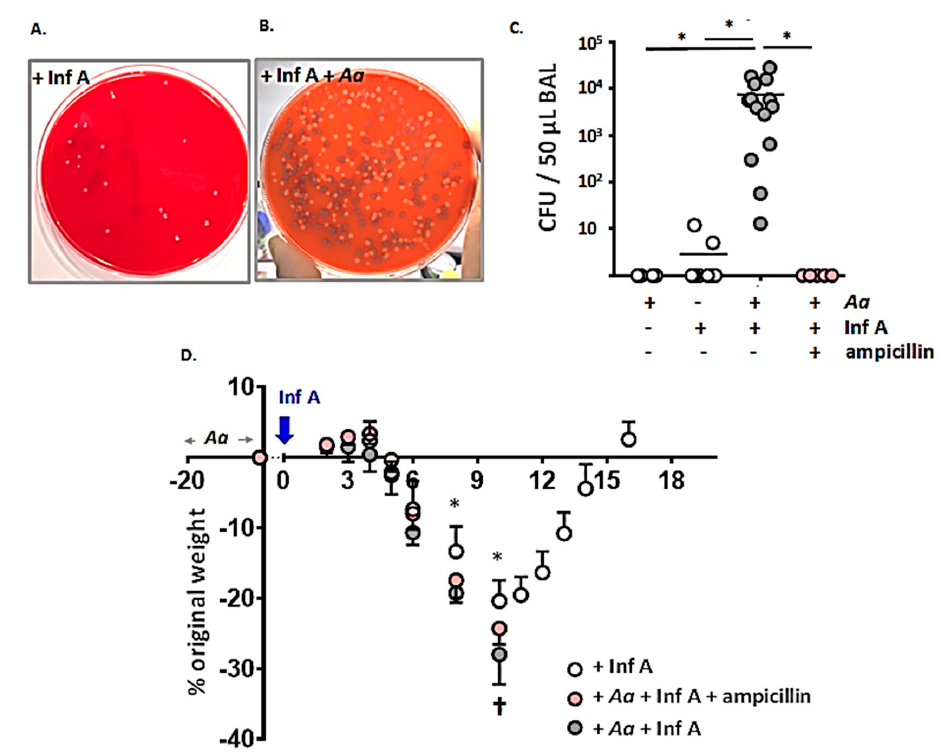
Figure 4. Bacterial colonization of the airways of A. alternata -challenged, Inf A-infected mice. Overnight growth at 37 ◦ C on blood agar plates streaked with dilutions of BAL fluid from ( A ) a mouse infected with a sublethal inoculum of Inf A only and ( B ) a mouse subjected to repetitive inoculation with A. alternata (5 µ g per inoculum) prior to Inf A infection. Both samples were from day 8 as per the timeline shown in Figure 1A. ( C ) Colony forming units (CFUs) per 50 µ L BAL fluid on day 8 as per the timeline in Figure 1A. Shown are results from mice challenged with A. alternata alone, sublethal Inf A alone, A. alternata followed by Inf A, and A. alternata followed by Inf A and ampicillin (20 mg / mouse / day i.p. on days 0–8.) ( D ) Total body weight over time for mice in groups indicated in ( C ); mice treated with A. alternata alone (5 µ g per inoculum) do not lose weight; n = 10 mice per group, * p < 0.05, 1-way ANOVA; † no survival after this time point in groups indicated.